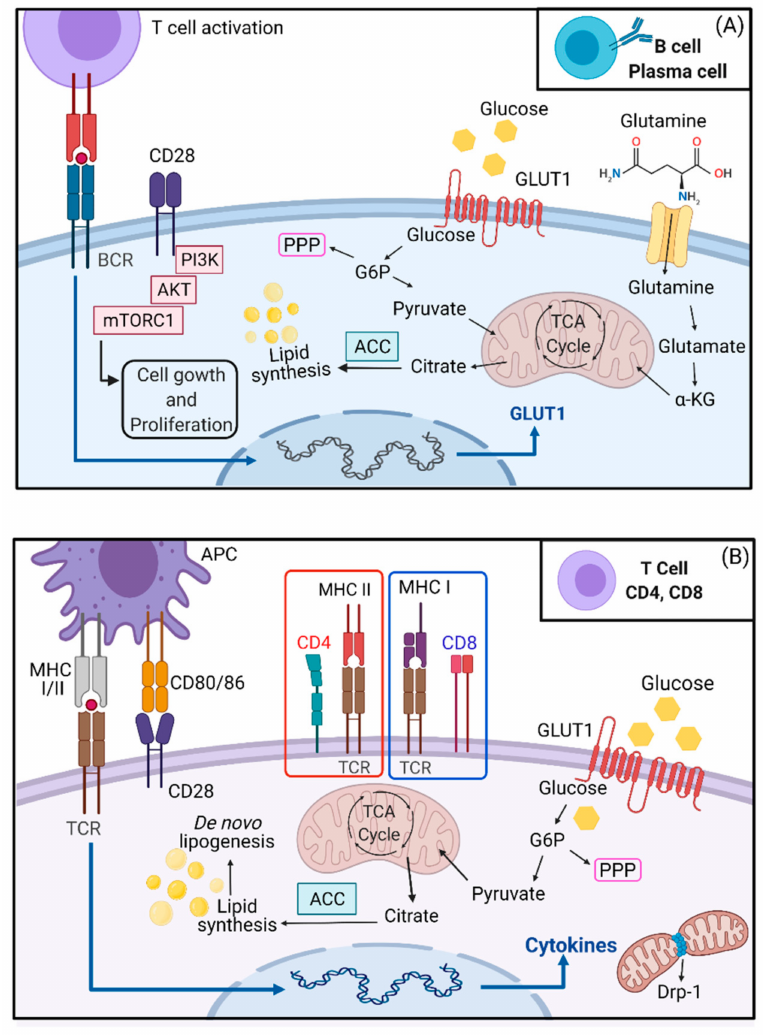
Figure 2. B and T cell activation and metabolism. ( A ) B cells (plasma cells) are activated by a T cell via BCR. Transcription of GLUT-1 is increased and favors glucose uptake and aerobic glycolysis. The pentose phosphate pathway (PPP) is required for redox balance and nucleotide synthesis whereas pyruvate and α KG go to the TCA cycle. Citrate excess is redirected to lipid synthesis. CD28 activation is required for long-lived plasma cells by stimulating growth and proliferation. ( B ) T cell activation occurs via APCs, in which MHC I or II binds to TCR and the co-stimulatory CD28. Drp-1 regulates mitochondrial fission playing an important role in metabolic reprogramming, proliferation, and migration in activated T cells. Glycolysis is upregulated and most of the pyruvate is excreted from the cell as lactate. Citrate from the TCA cycle is used for lipid synthesis. The PPP is important for generating NADPH and nucleotide synthesis. Abbreviations: CD: cluster of differentiation; TCA: tricarboxylic acid cycle; G6P: glucose-6-phosphate; GLUT-1: glucose transporter; Drp-1: dynamin related protein-1; TCR: T cell receptor; MHC: major histocompatibility complex; APC: antigen presenting cell; ACC: acetyl-CoA carboxylase. Created with